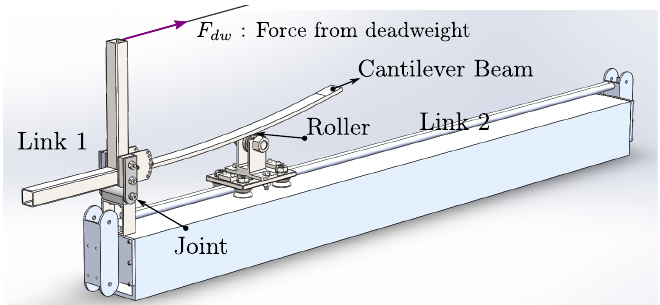
Figure 4. Schematic of test-rig structure. Cable is used to apply forces using deadweights.